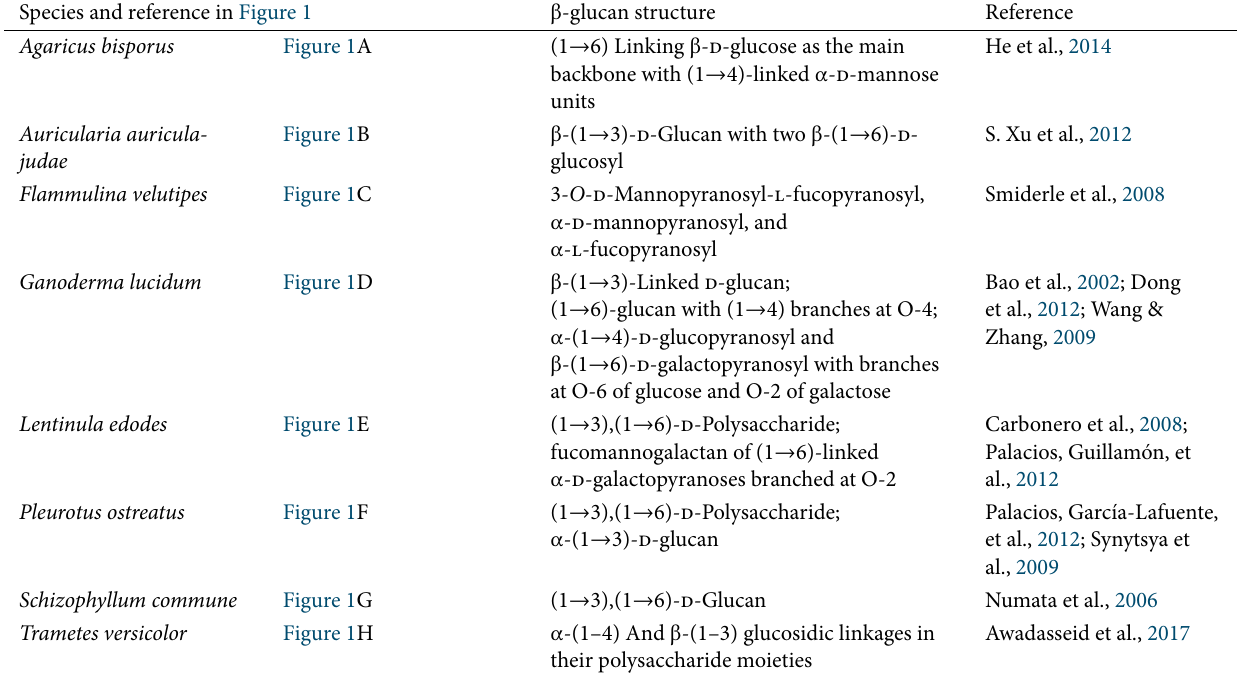
Awadasseid et al.,